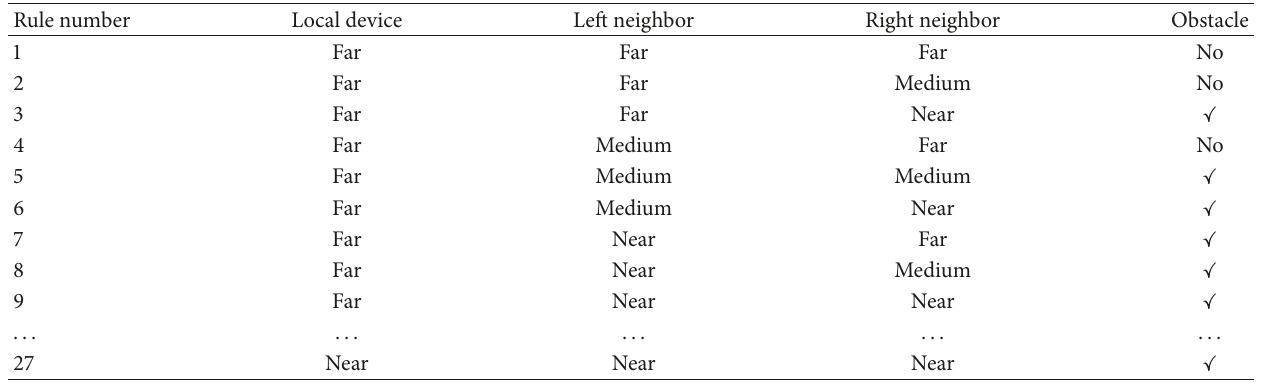
Table 3: Rule base for the ultrasound fuzzy controller.